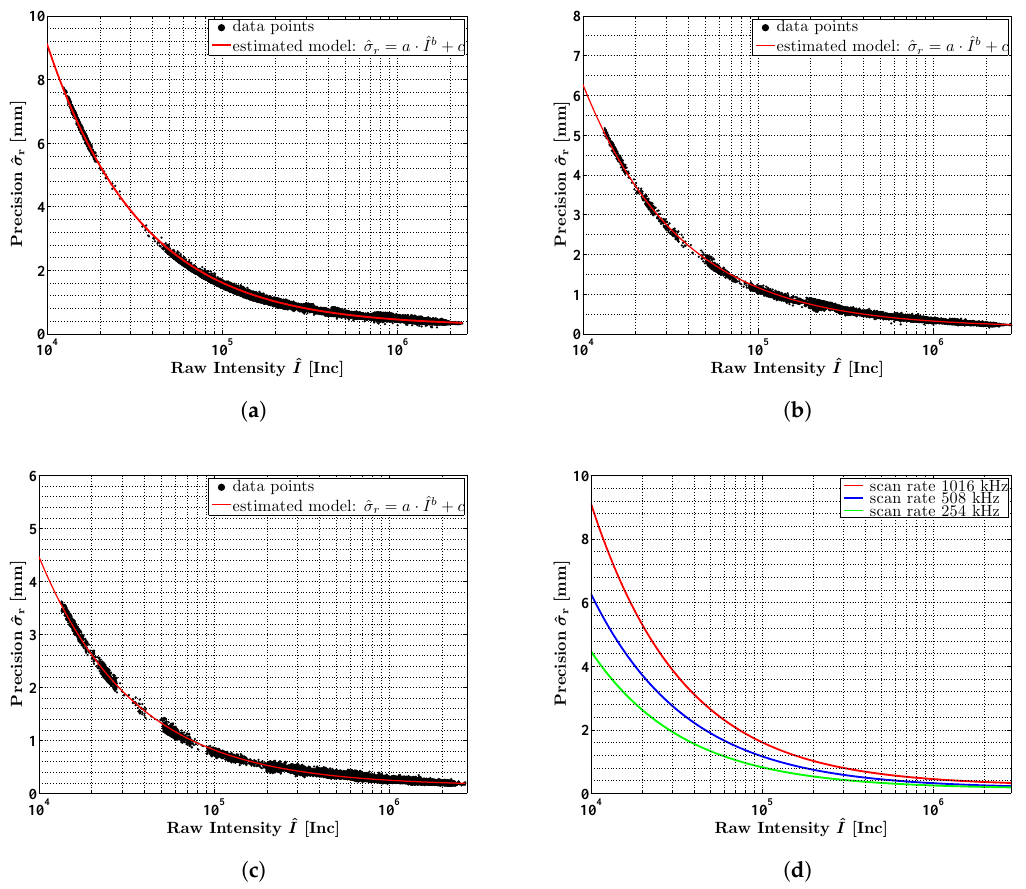
Figure 8. Intensity-based stochastic models for the precision of the distance measurements of the Z + F Profiler 9012A for different scan rates: ( a ) 1016 kHz; ( b ) 508 kHz; ( c ) 254 kHz; ( d ) all